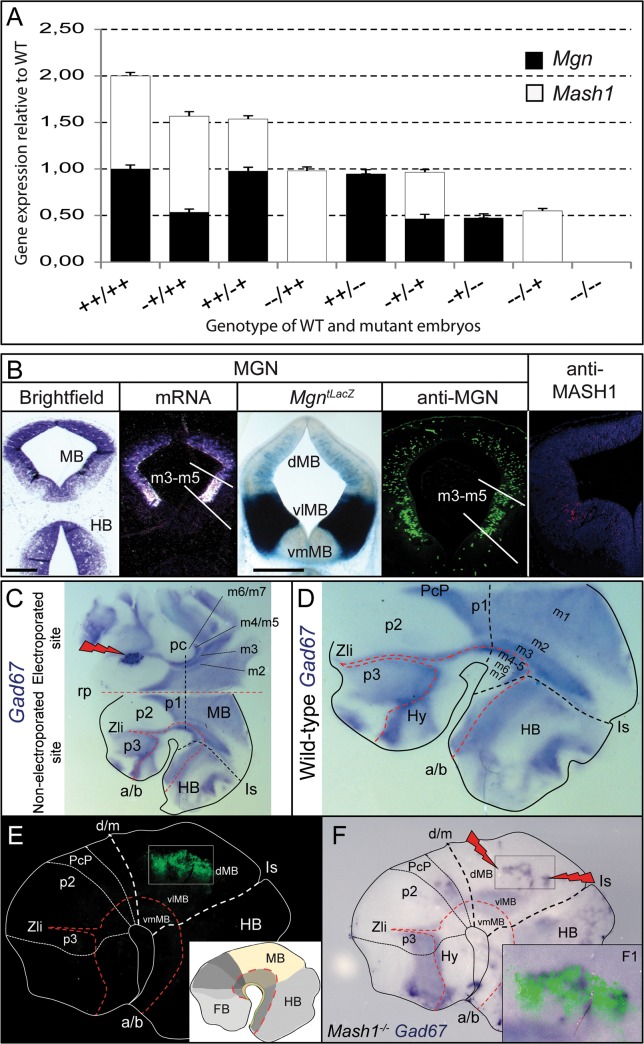
Endogenous and ectopic expression of Mgn.
(A) Relative expression levels of Mgn and Mash1 in mutant to wild-type mice. The bar height and error bars show the mean and standard deviation, respectively. (B)
Mgn mRNA was expressed at high levels in the vlMB of E12.5 mouse embryos compared with the low level of expression in the dMB determined by ISH, LacZ staining of Mgn
tLacZ mice, and IHC of wild-type embryos with the anti-MGN antibody on coronal sections. The lines indicated the borders of m3-m5 domains. MASH1 protein is also expressed at higher levels in the vlMB compared with its dorsal expression, as determined by IHC with anti-MASH1 antibody. (C) WISH was performed with Gad67 probe in ONTC of wild-type E11.5 embryos with Mgn cDNA electroporated in one of the sides (right side), whereas the other side served as a control (left side). The neural tube is opened along the ventral anterior-posterior axis. Lightning bolt icons point to the ectopic expression of Gad67 after Mgn electroporation. Subdomains are shown according to the prosomeric model [21]. (D) WISH was performed with a Gad67 probe in the ONTCs of E11.5 wild-type mouse embryos after 10 h of incubation. The red dashed line delineates the alar/basal (a/b) boundary. The black dashed lines delineate the transversal neural tube domain boundaries. (E and F) E11.5 Mash1
−/− ONTCs 24 h after micro-electroporation in the mesencephalic alar plate with the Mgn-IRES-EGFP plasmid. (E) A fluorescence signal showing the electroporated location. (F) Induction of Gad67 expression after electroporation of Mgn cDNA in Mash1
−/− background embryos. (F1) A merged profile of the fluorescence signal and Gad67 induction. Scale bars: 500 μm. Abbreviations: a/b, alar/basal plate boundary; d/m, diencephalic–mesencephalic boundary; Hy, hypothalamus; Is, isthmus; p1–p3, prosomeres 1 to 3 in diencephalon; PcP, precommissural domain in the pretectum (p1); rp, roof plate; Zli, zona limitans intrathalamica.